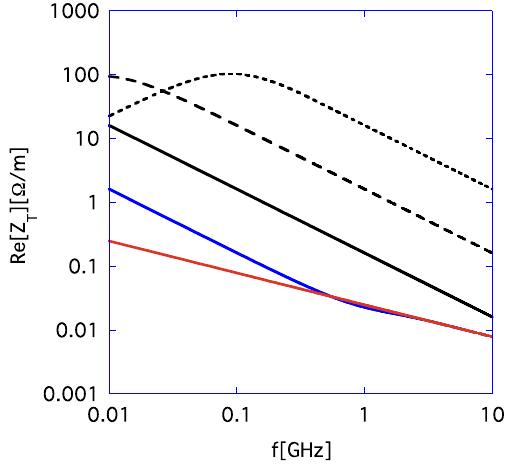
FIG. 8. (Color) The real part of the transverse impedance per a unit length for the case that the thickness of the insert t is equal to 10 nm and Lorentz factor (cid:6) is equal to 1000. The red, the blue, and the black lines show the case the length of the insert g is equal to 2, 8, and 18 mm, respectively.